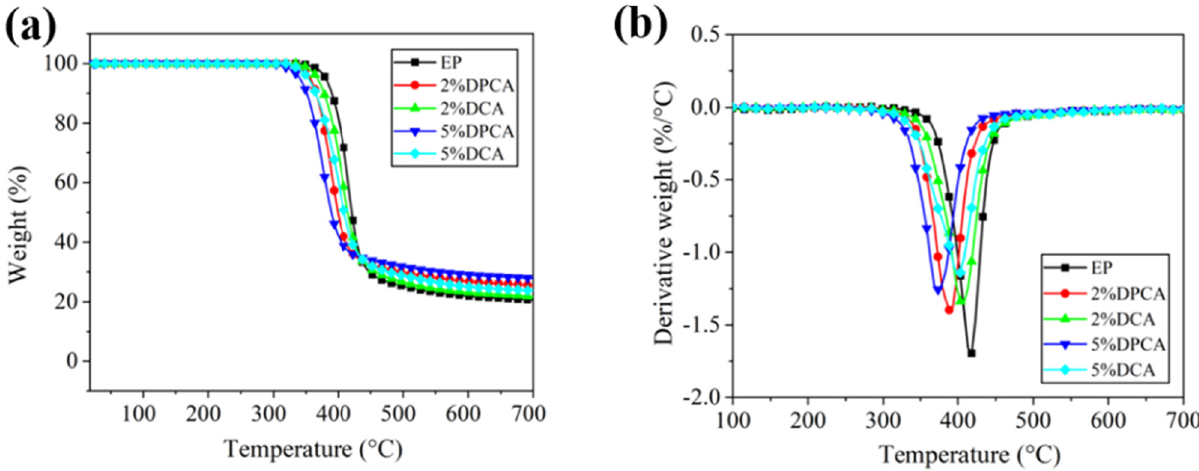
Figure 3: ( a ) TG and ( b ) DTG curves of EP, EP - 2 wt% DPCA, EP - 2 wt% DCA, EP - 5 wt% DPCA, and EP - 5 wt% DCA in